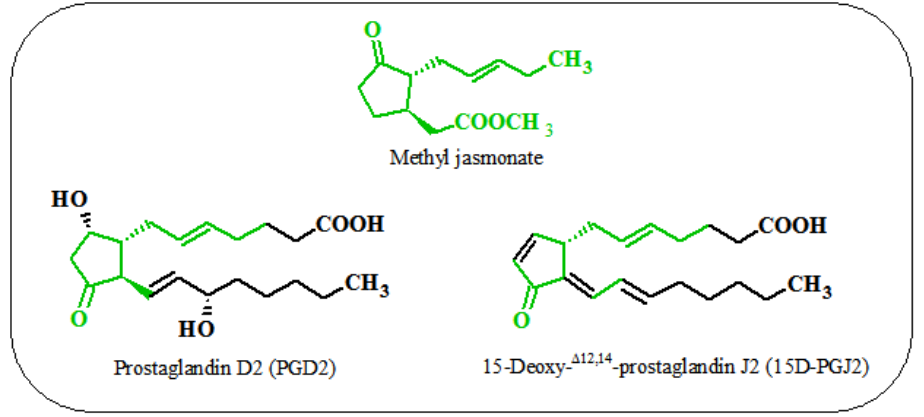
Figure 5. Similarities between jasmonates and prostaglandins.